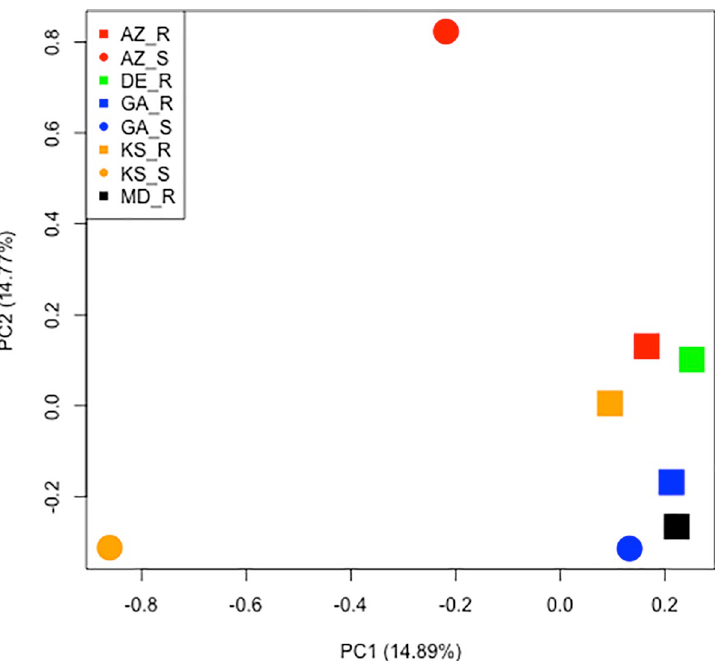
Fig 6. Hierarchal clustering by principal components of genome-wide SNPs. Principal component clustering using ~15k genome-wide SNPs pruned for linkage equilibrium of GR and GS individuals from geographically distant